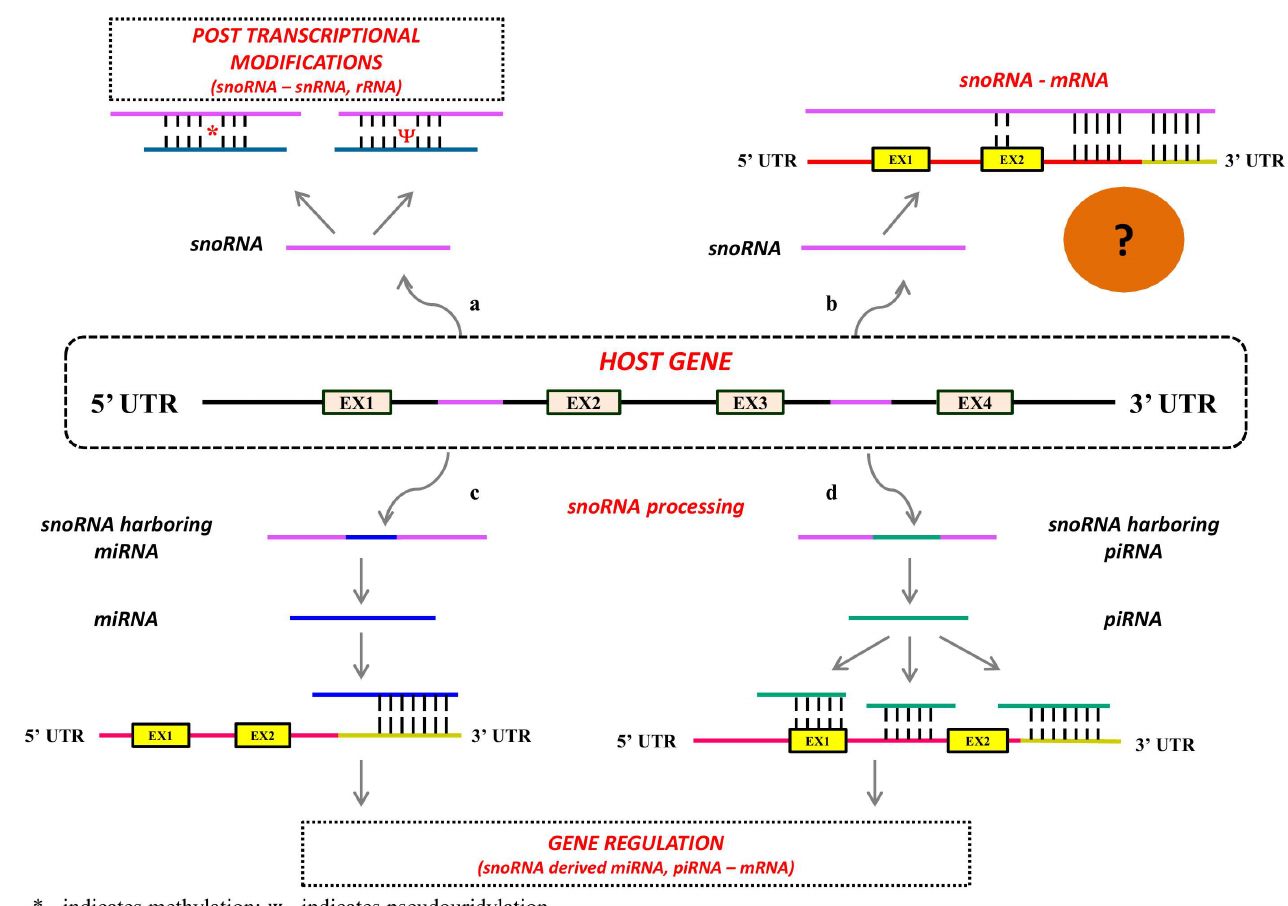
Fig 4. Complex interplayof snoRNAswithotherRNAs. snoRNAs are involved in diverse biologicalfunctions. They arisefromthe intronic regionsof proteincoding / non-proteincoding genes (hostgenes).EX representsexons. Black lines indicateintronicregionsand purplelines withinintronicregions indicatethe coding regions for snoRNAs. The canonical functionof snoRNAs is its role in post-transcriptionalmodifications of snRNAs and rRNAs, which are involved in splicing mechanism and proteintranslation,respectively (a).One of the emergingroles of snoRNAs is its involvement in gene regulation. snoRNAs may act as a source for othersmall RNAs such as miRNAs (b, indicated in deep blue) and piRNAs (c, indicatedin green).miRNAs and piRNAs are considered as masterregulators of gene expression that may bind to the untranslatedregions(3’ UTR or 5’ UTR),exons or intronsand may promoteeithermRNA degradation or translation inhibition;implyingthe indirectrole of snoRNAs in gene regulation. (d).The otherunknown functionof snoRNAs is its directinteraction with mRNAs throughcomplementarybase pairing.To-date, the directinteraction of snoRNAs with mRNAs has not been studied;however, this interaction mightbe a possibility based on the demonstrated subsets of snoRNAs embedding piRNAs and miRNAs, and their interactions with mRNAs throughbase pair complementarities;furtherresearch into this field may enhanceour understanding on the directrole of snoRNAs in gene